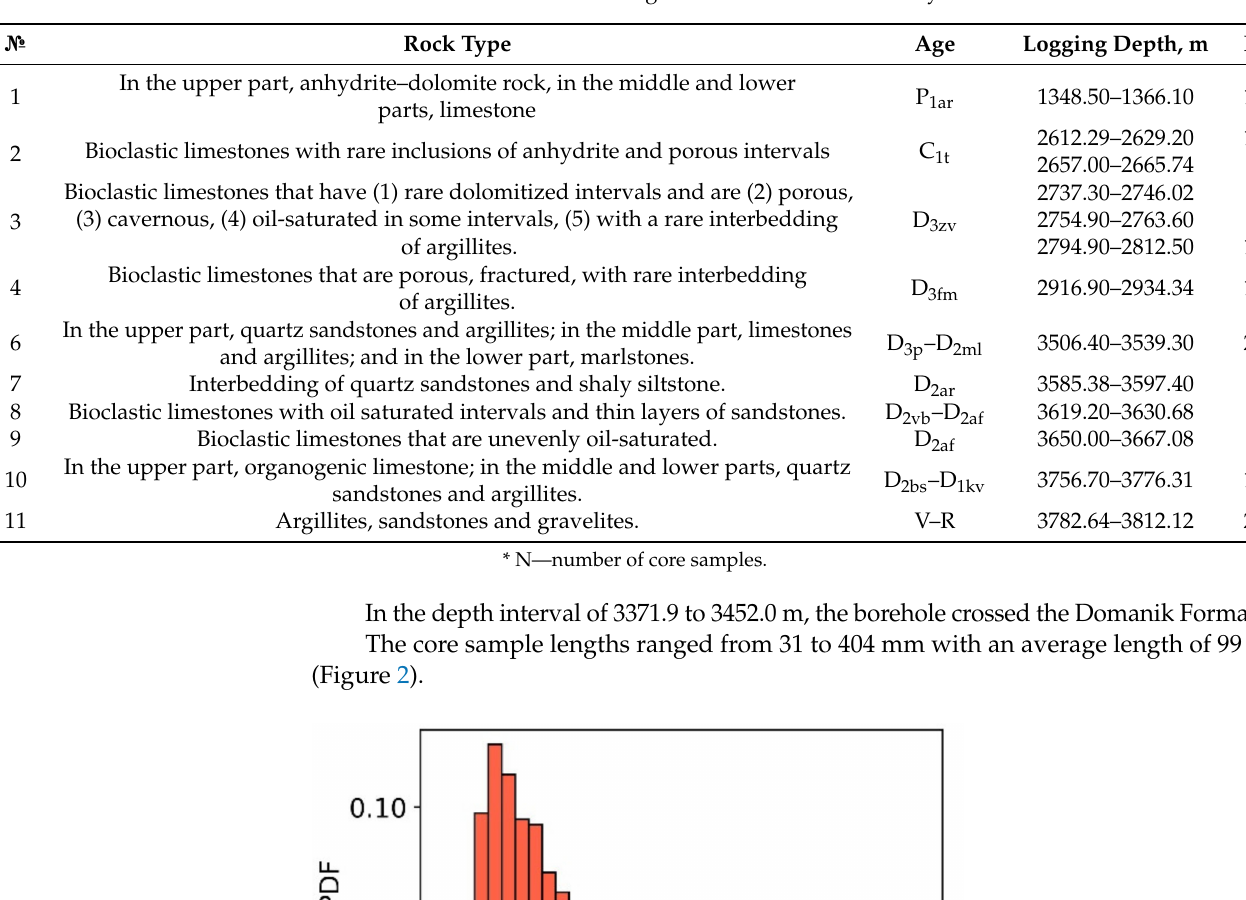
Table 1. Characteristics of the sediments from the investigated well based on the analysis of the recovered cores.